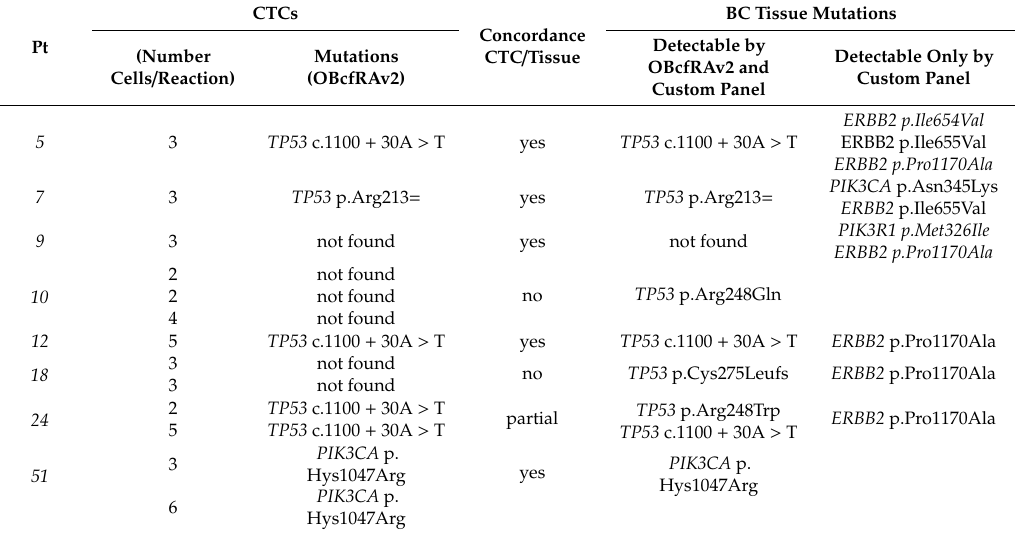
Table 3. Mutational comparison between CTCs and corresponding tumor breast